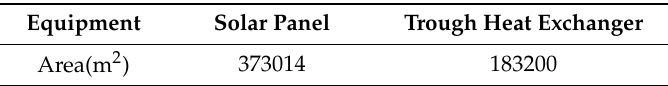
Table 9. Materials of solar–hybrid